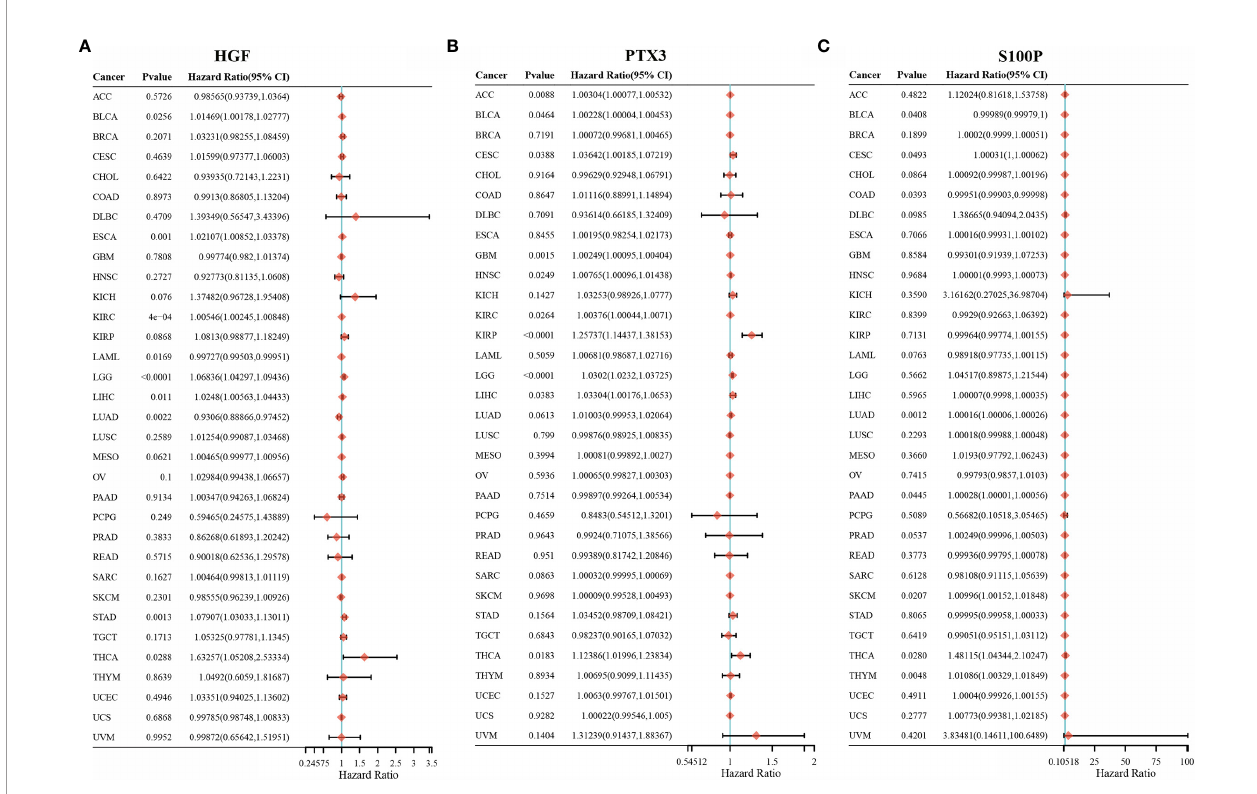
FIGURE 7 | HGF, PTX3, S100P on the prognosis of other cancers. (A) Forest plot of HGF on the prognosis in 33 cancer types; (B) Forest plot of PTX3 on the prognosis in 33 cancer types; (C) Forest plot of S100P on the prognosis in 33 cancer types.